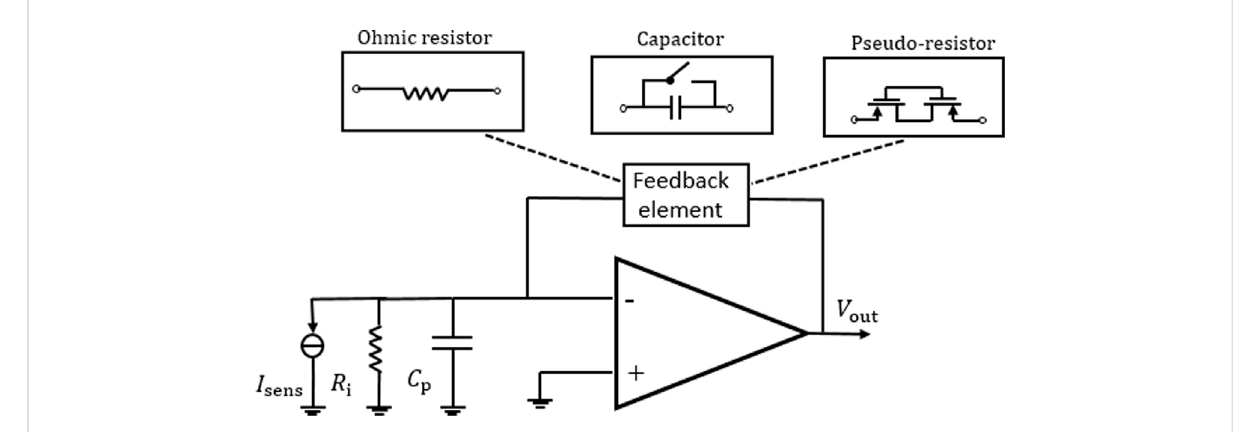
FIGURE 5 TIA with three different feedback elements (Djekic et al.,